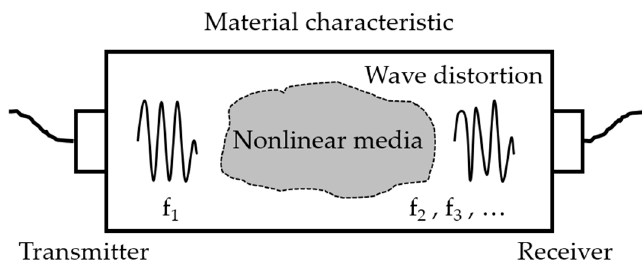
Figure 1. Wave propagation in nonlinear media.